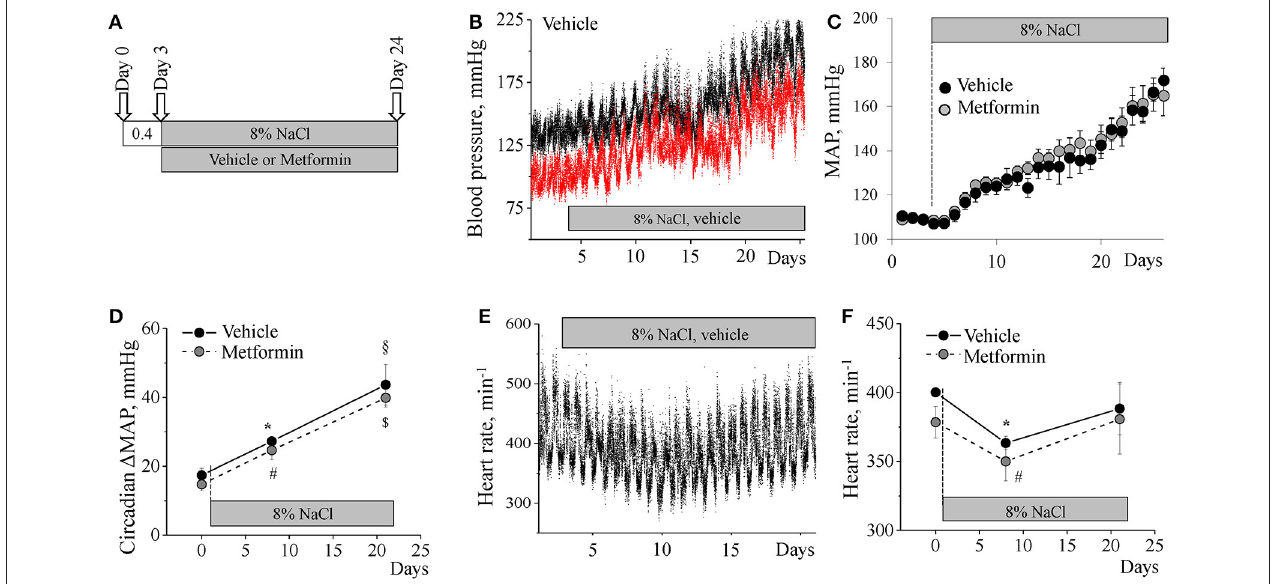
FIGURE 2 | Metformin does not alter the development of SS hypertension. (A) Experimental protocol for BP recording. Continuous BP acquisition via catheters was performed in conscious Dahl SS rats placed on an 8% NaCl diet and subjected to an intravenous infusion of metformin ( n = 9) or vehicle ( n = 6). (B) Representative systolic (black) and diastolic (red) blood pressure recordings from a vehicle-treated animal. Data were averaged in 1 min intervals. (C) Mean arterial blood pressure (MAP) in the vehicle- and metformin-treated groups. (D) Metformin does not affect MAP circadian dipping increase during development of hypertension. (E) Representative heart rate trace acquired from a vehicle-treated animal. (F) Lack of effect of metformin on heart rate in experimental animals. *, # p < 0.05 vs. 0.4% NaCl; § , $ p < 0.05 vs. 8 days on 8% NaCl.